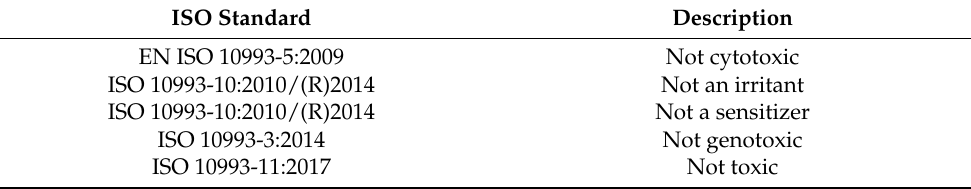
Table 3. Evaluation of biocompatibility of the investigated material Dental LT Clear